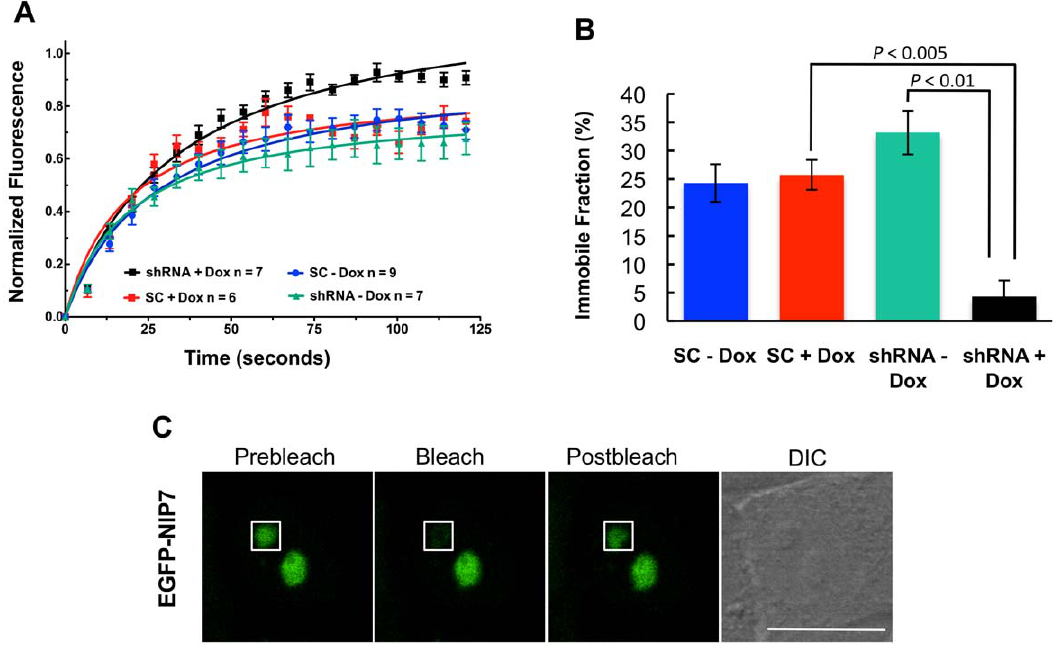
Figure 5. NIP7 shows different binding kinetics at the nucleolus under FTSJ3 depletion. ( A ) Fluorescence recovery after photobleaching (FRAP) was measured for EGFP-NIP7 in HEK293 Flp-In T-Rex cells expressing either a shRNA targeting FTSJ3 or a scrambled control (SC) and induced ( + ) or not ( 2 ) with doxycycline (Dox). The graph shows normalized mean fluorescence recovery curves over time calculated for EGFP-NIP7 at the nucleolus. Means were plotted with standard errors for each time point. ( B ) Graph of the 120-seconds time point postbleach. Data are representative of two independent experiments with at least 6 cells analyzed in each experiment. P -value was obtained by using a one-sided Student’s t-test. ( C ) Images of a representative cell showing EGFP-NIP7 fluorescence before photobleaching (prebleach), immediately after photobleaching (bleach), and after 120 seconds when the fluorescence has already recovered (postbleach). The white box indicates the region of interest used in the analysis. The scale bar represents 30 m m.